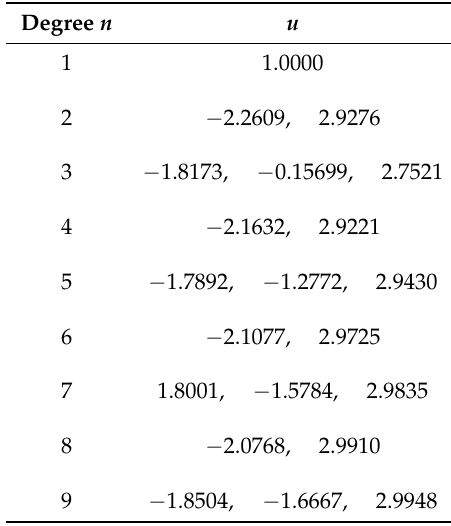
( m ) ( u , v ) = 0 for u ∈ R . n , q